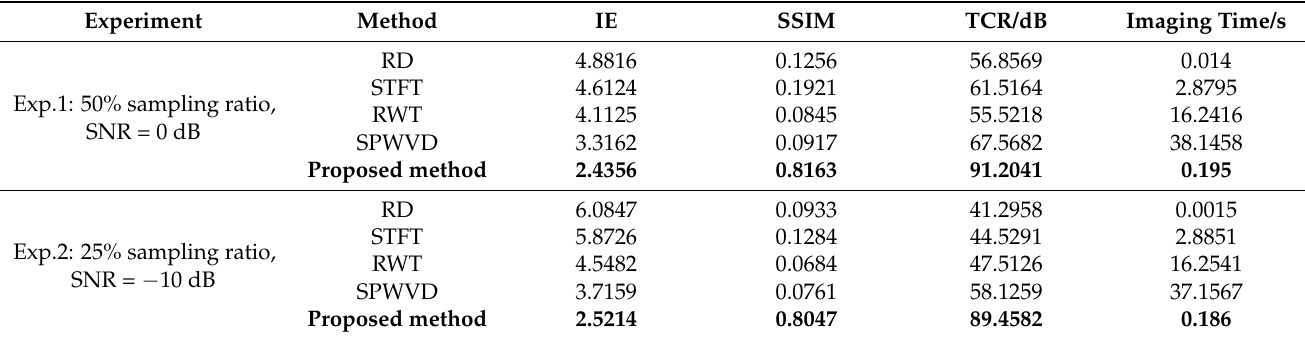
Table 5. The evaluation indicators of different methods under sparse